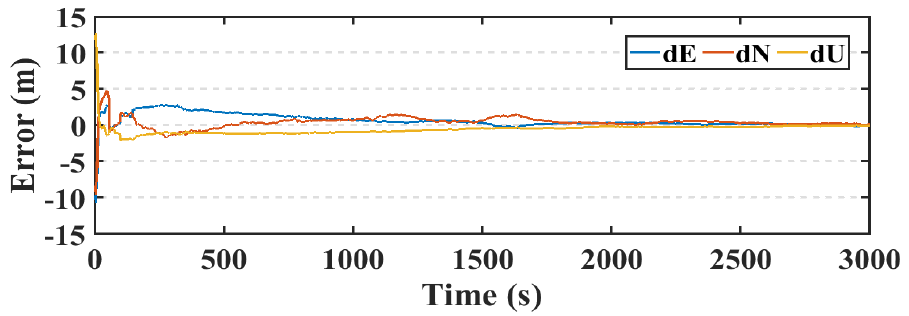
Figure 22. Position errors for the post-processed PPP solution (static/second dataset).